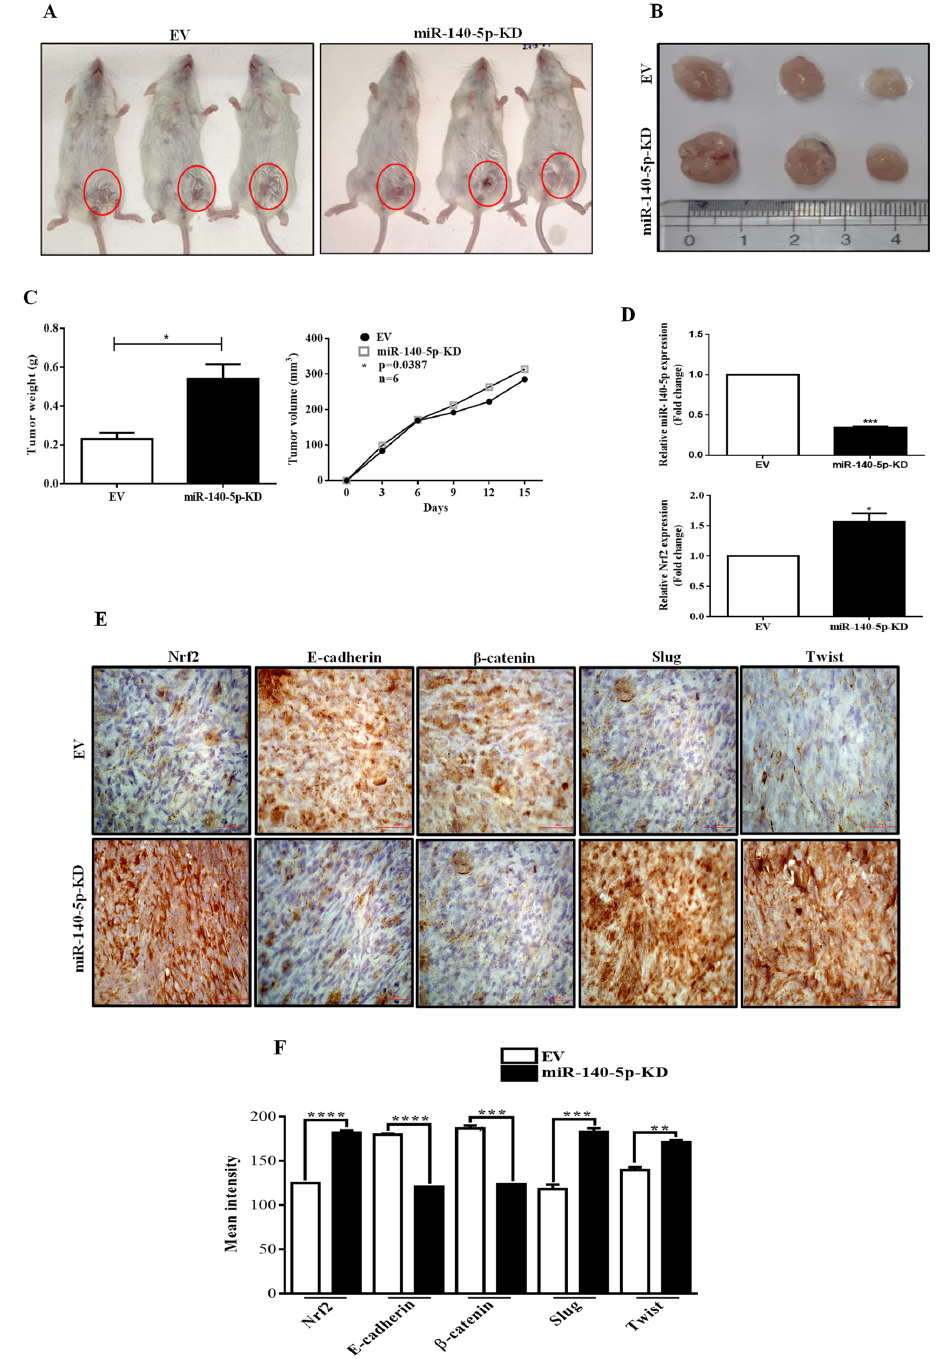
Figure 8. Tumorigenicity assay in a mouse model. ( A , F ) EV or miR ‐ 140 ‐ 5p ‐ KD MDA ‐ MB ‐ 231 cells were subcutaneously administered into the mammary fat pad of NOD/SCID mice. ( B ) NOD/SCID mice xenograft tumors. ( C ) Average tumor weight and volume (mm 3 ) were plotted. ( D ) miR ‐ 140 ‐ 5p and Nrf2 expression in xenograft tumors as measured by qRT ‐ PCR. ( E ) IHC staining of the EMT markers in the xenograft tumors (60x objective lens). Error bars indicate mean ± SEM ( n = 3). Student’s t ‐ tests were used to compare the means of two groups. * p < 0.05, ** p < 0.01, *** p < 0.001, and **** p < 0.0001 compared to EV.